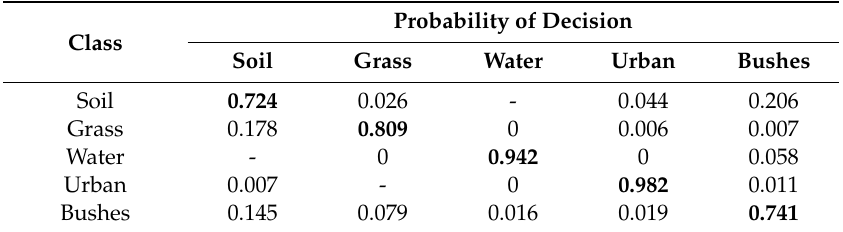
Table 17. Classification probabilities (confusion matrix) for the MLM trained for the original image and applied to the compressed image (PSNR-HVS-M = 30 dB).